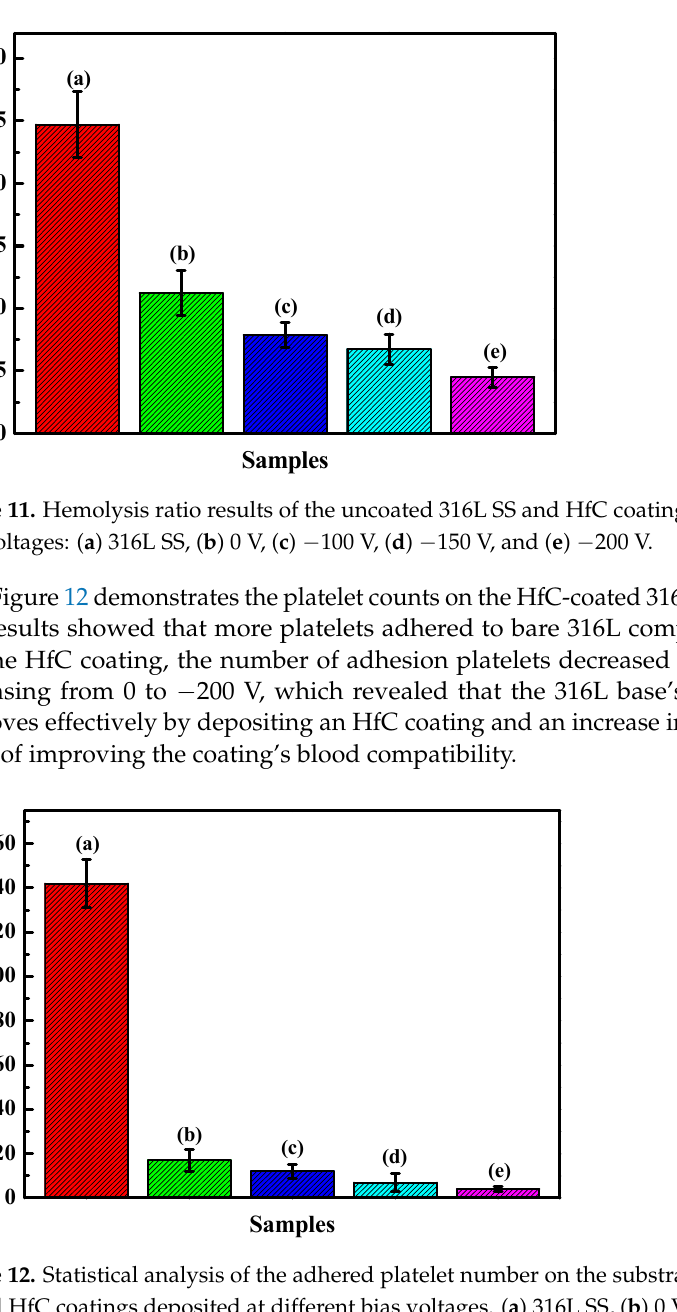
Figure 12. Statistical analysis of the adhered platelet number on the substrate of the uncoated 316L SS and HfC coatings deposited at different bias voltages. ( a ) 316L SS, ( b ) 0 V, ( c ) − 100 V, ( d ) − 150 V, and ( e ) − 200 V.